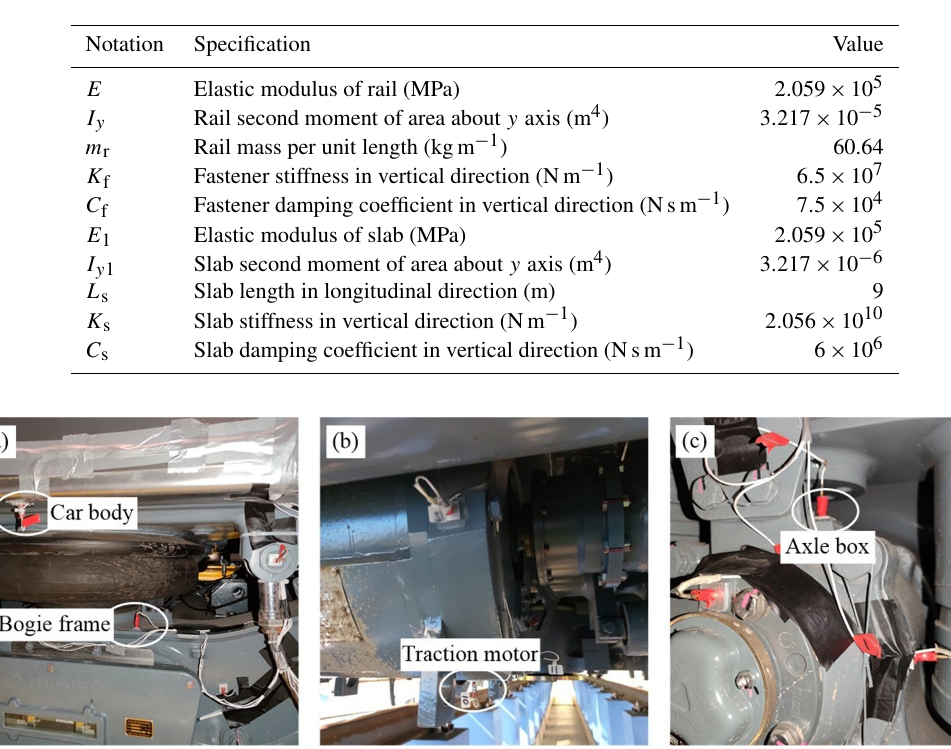
Table 3. Main parameters of the slab-track structure.